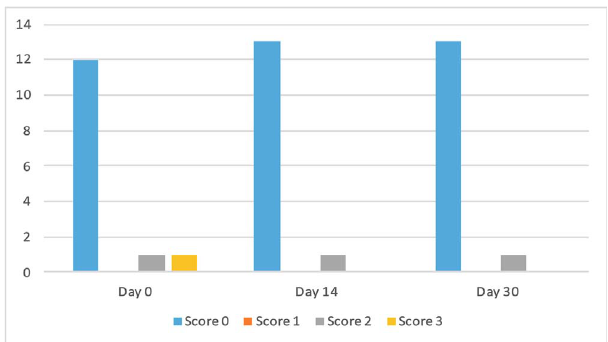
Figure 4. Number of cats according to the clinical score for hair loss in Group 1 (NexGard Combo (cid:1) ).